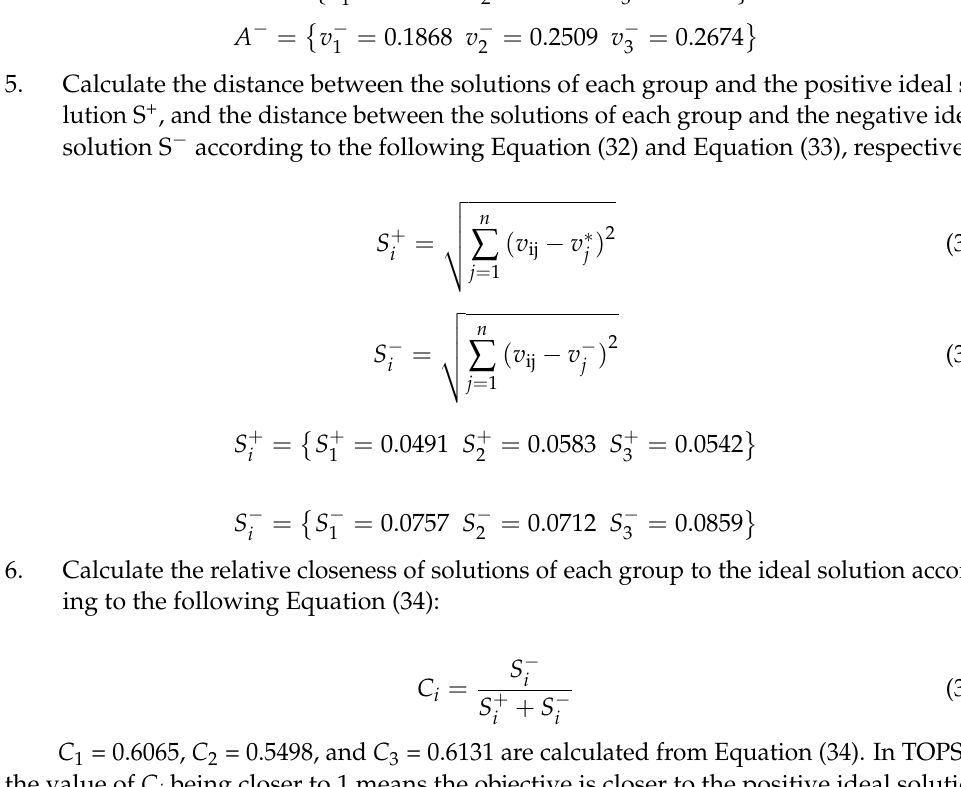
5. Calculate the distance between the solutions of each group and the positive ideal so- lution S + , and the distance between the solutions of each group and the negative ideal solution S − according to the following Equation (32) and Equation (33), respectively.